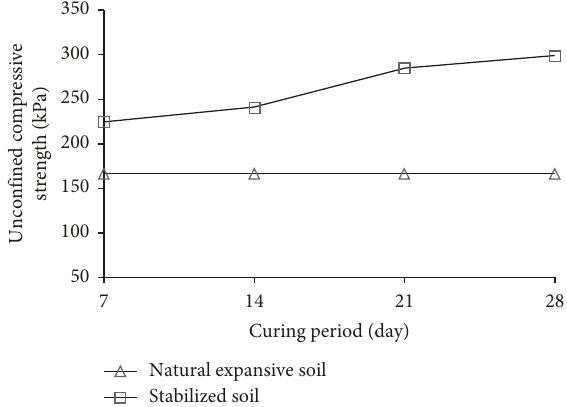
Figure 5: Unconfined compression strengths for samples with different curing periods.